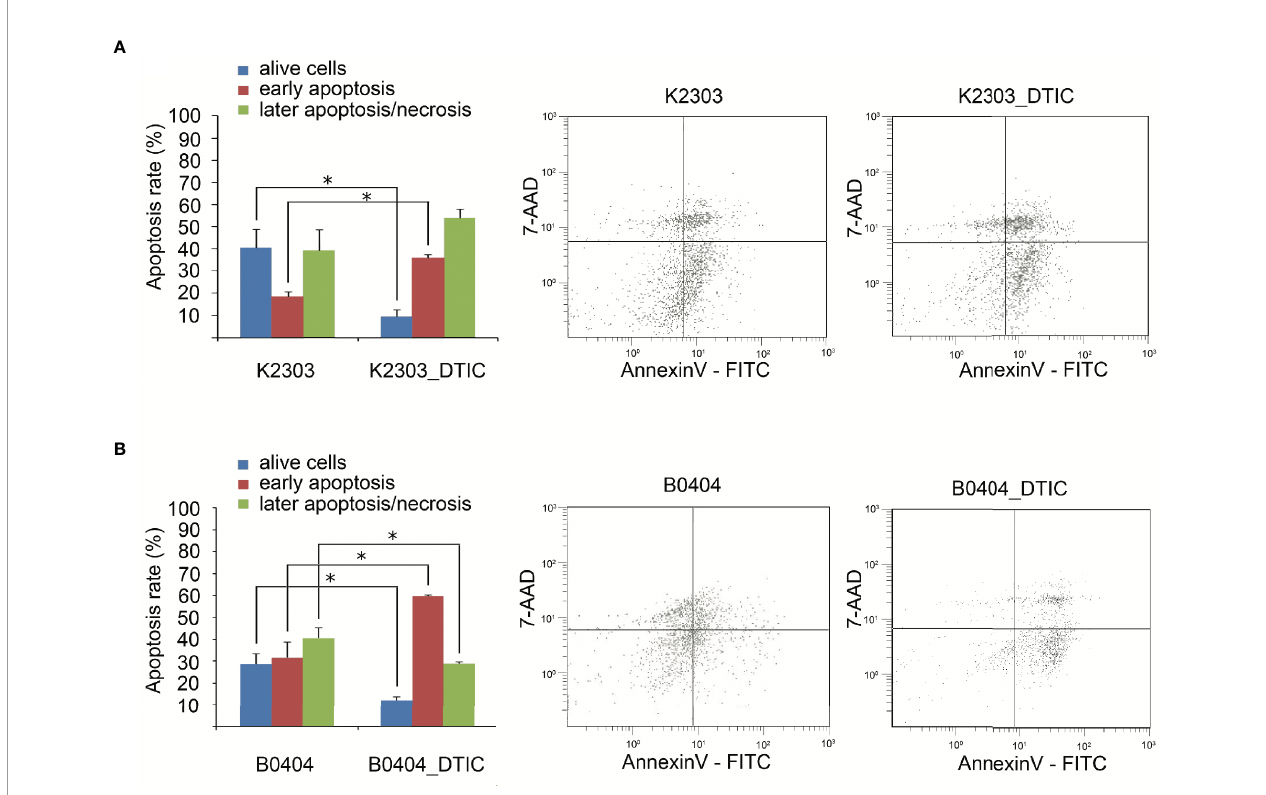
FIGURE 2 | Effect of dacarbazine at 5.5 mM on the apoptosis of melanoma cells according to the results of the annexin V/7-aminoactomycin fl ow cytometry assay. (A) The percentages of live, early-apoptotic, late-apoptotic and necrotic cells are shown in the two-parameter scatterplots for K2303 melanoma cells. (B) The percentages of live, early-apoptotic, late-apoptotic and necrotic cells are shown in the two-parameter scatterplots for B0404 melanoma cells. Data are presented as the mean±SEM. *P<0.05 by Mann-Whitney U test for unpaired